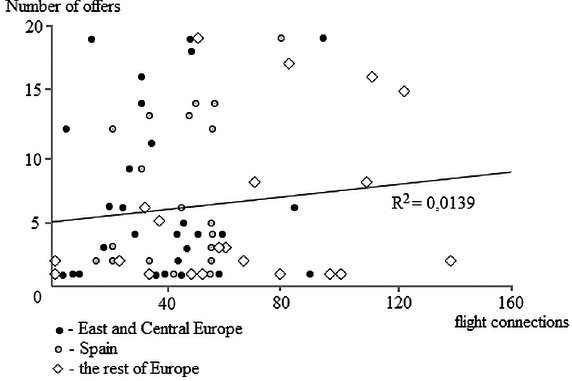
Fig. 6. Popularity of stag party tourism destinations in relation to nightlife infrastructure based on the analyzed offers and data from TripAdvisor.